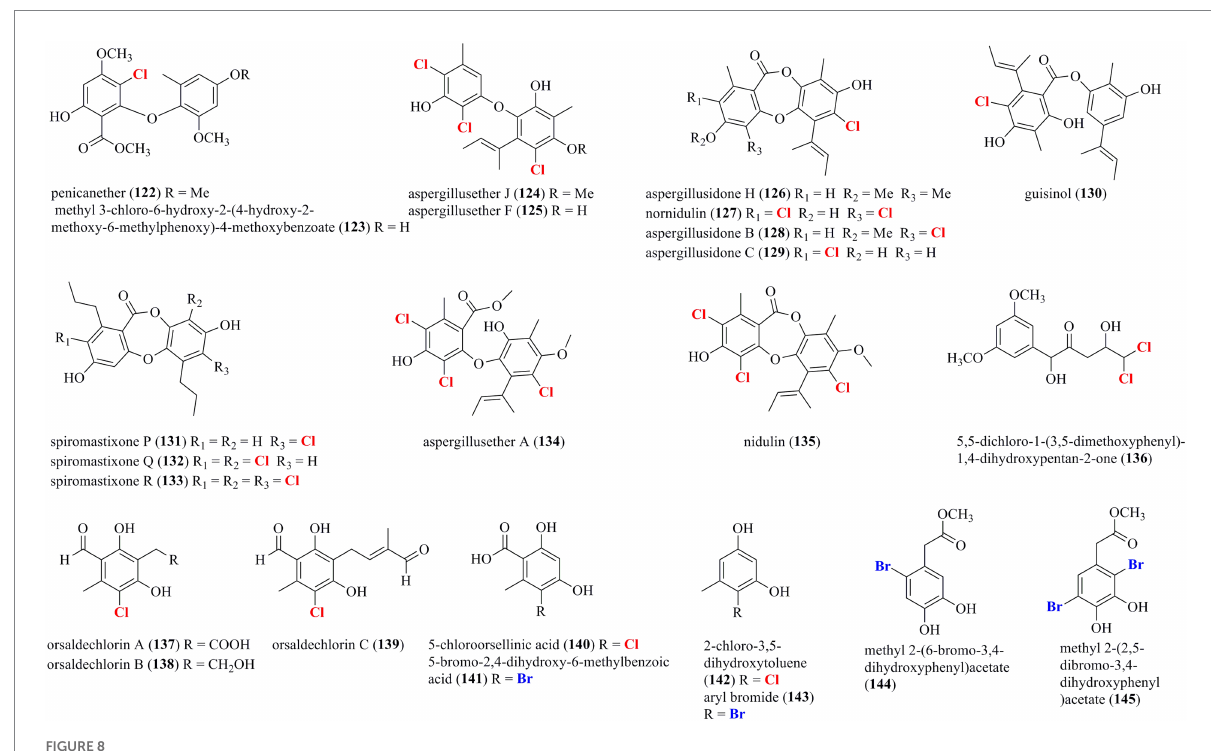
FIGURE 8 Halogenated phenolic derivatives from marine-derived fungi ( 122–145